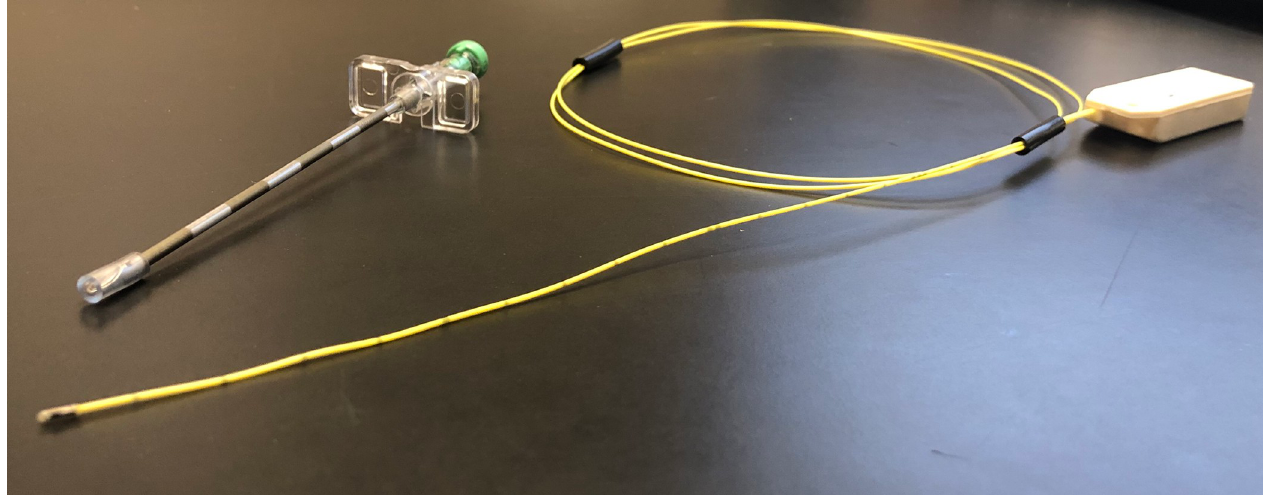
Fig 1. Fiberoptic monitor (Codman Microsensor Basic Kit, Integra LifeSciences Production Corporation, Mansfield, MA).